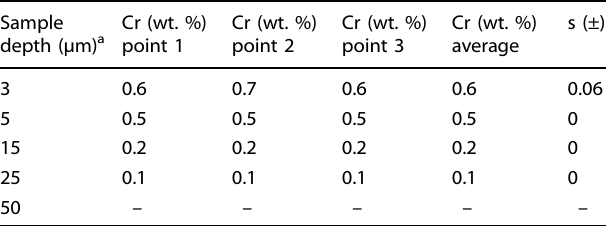
Table 1. Concentration of Cr at different sample depths for epoxy fi lm exposed to Na 2 CrO 4 solution in water/acetone for 24 h at 60